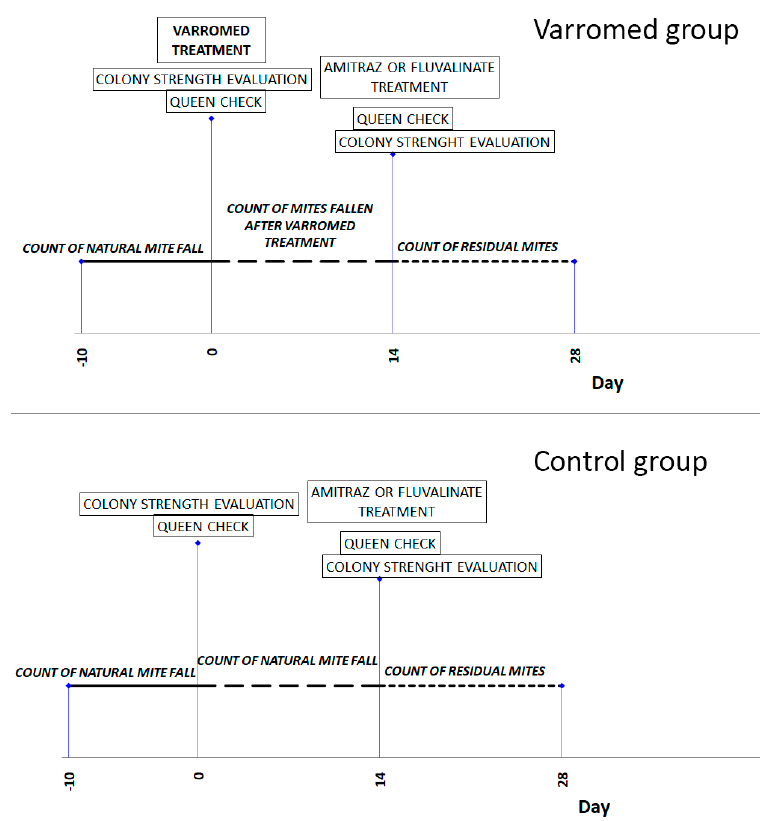
Figure 3. Winter protocol for the treated and control group in broodless colonies.